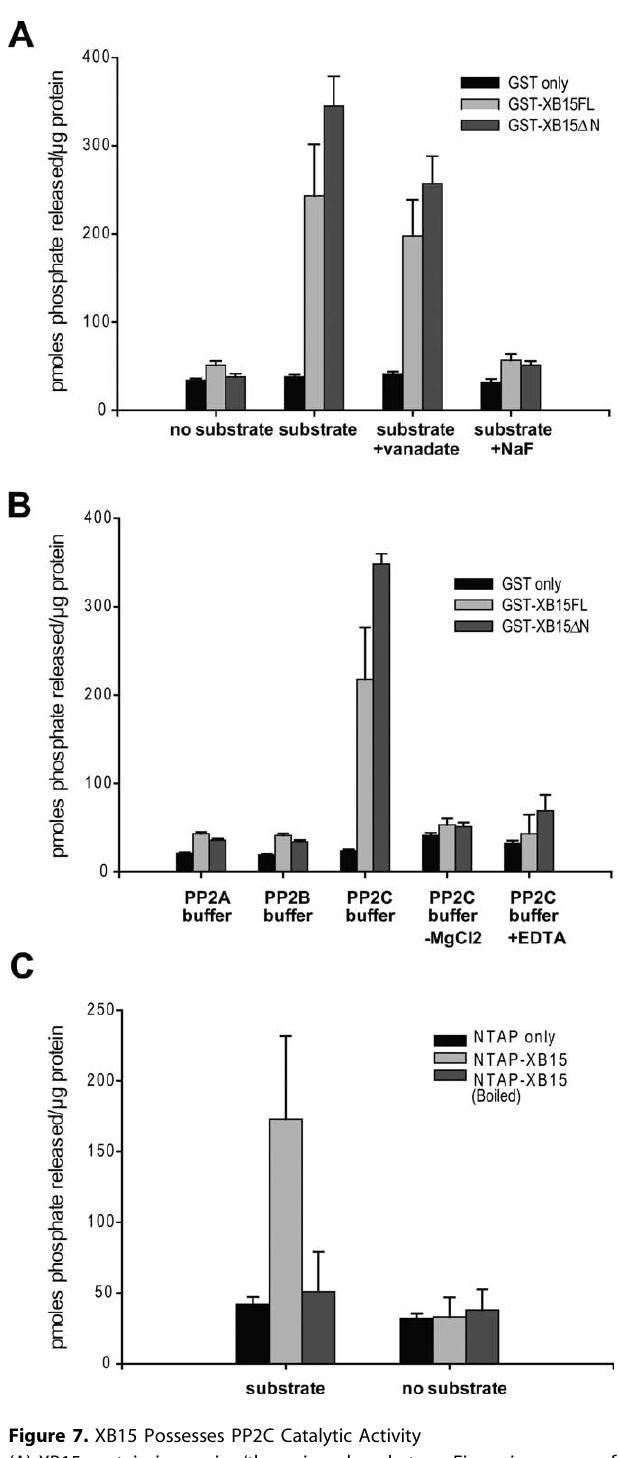
Figure 7. XB15 Possesses PP2C Catalytic Activity (A) XB15 protein is a serine/threonine phosphatase. Five micrograms of GST-XB15FL (full length XB15), GST-XB15 D N (catalytic domain only), or GST was incubated with: no substrate, 100 l M substrate, 100 l M substrate plus 1 mM sodium vanadate, 100 l M substrate plus 50 mM NaF. (B) XB15 protein is a PP2C. Five micrograms of GST-XB15FL, GST-XB15 D N, or GST was incubated with 100 l M substrate in each of the three buffers specific for PP2A, PP2B, and PP2C activity. (C) The XB15 protein purified from rice plants carries a PP2C activity. NTAP-XB15 and NTAP were purified from transgenic plants and 1 l g of each protein was incubated with 100 l M substrate in PP2C buffer. For the boiled NTAP-XB15, 1 l g of NTAP-XB15 was boiled in water for